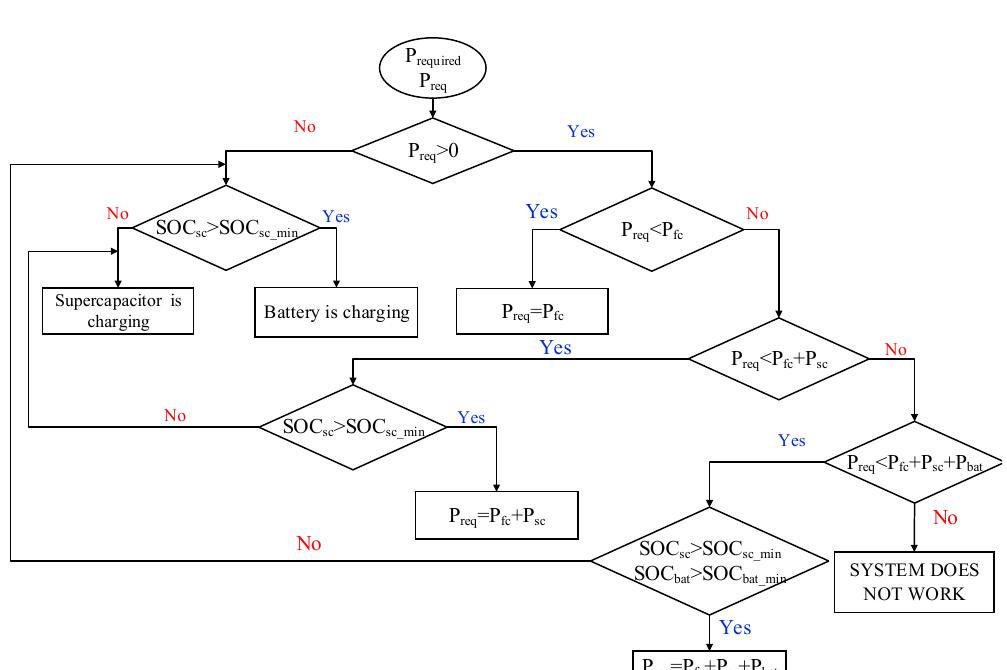
Figure 5. The flowchart of life cycle saving control strategy (LCS-CS)) [18].